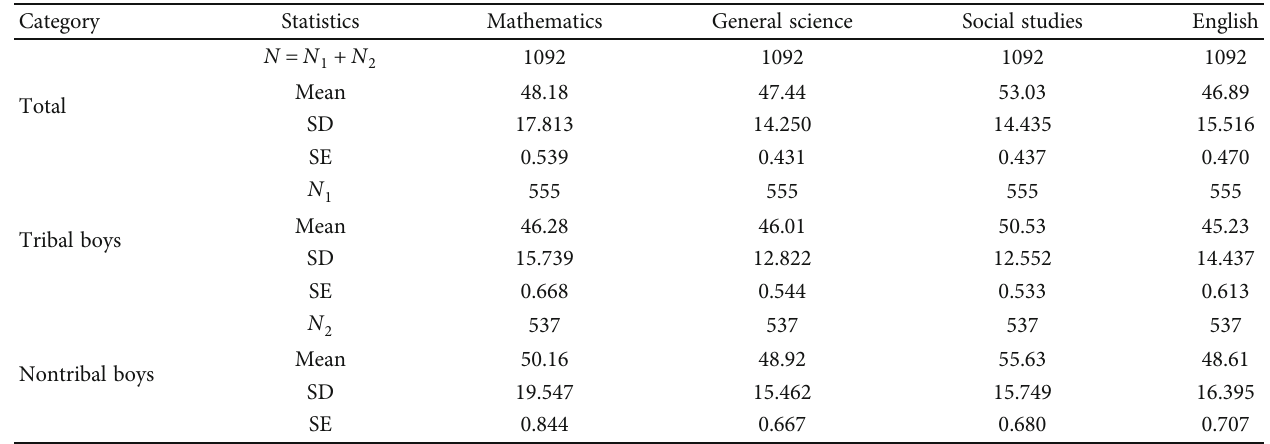
Table 10: The descriptive statistics for tribal boy and nontribal boy